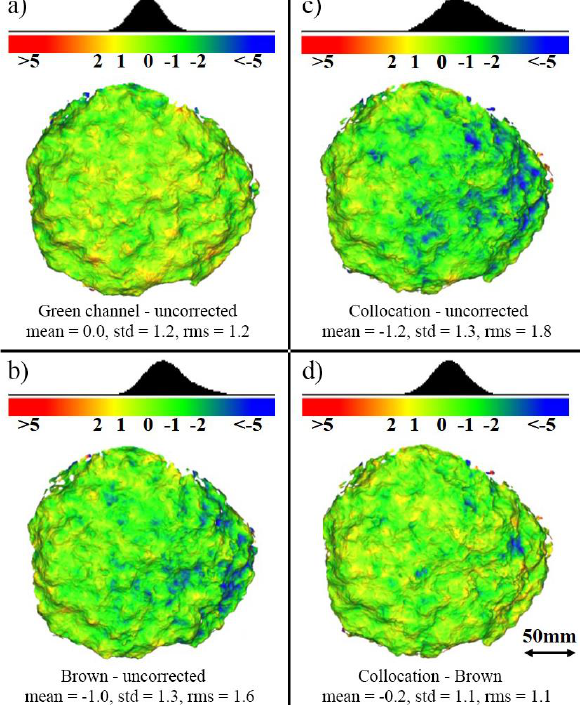
Figure 7. Comparison of dense point clouds for a single coral. a) to c) compare models generated by the green channel, the Brown dataset, and the collocated dataset with the uncorrected GoPro dataset. In d) the difference between the collocation and Brown datasets are shown. All numbers in millimeters.